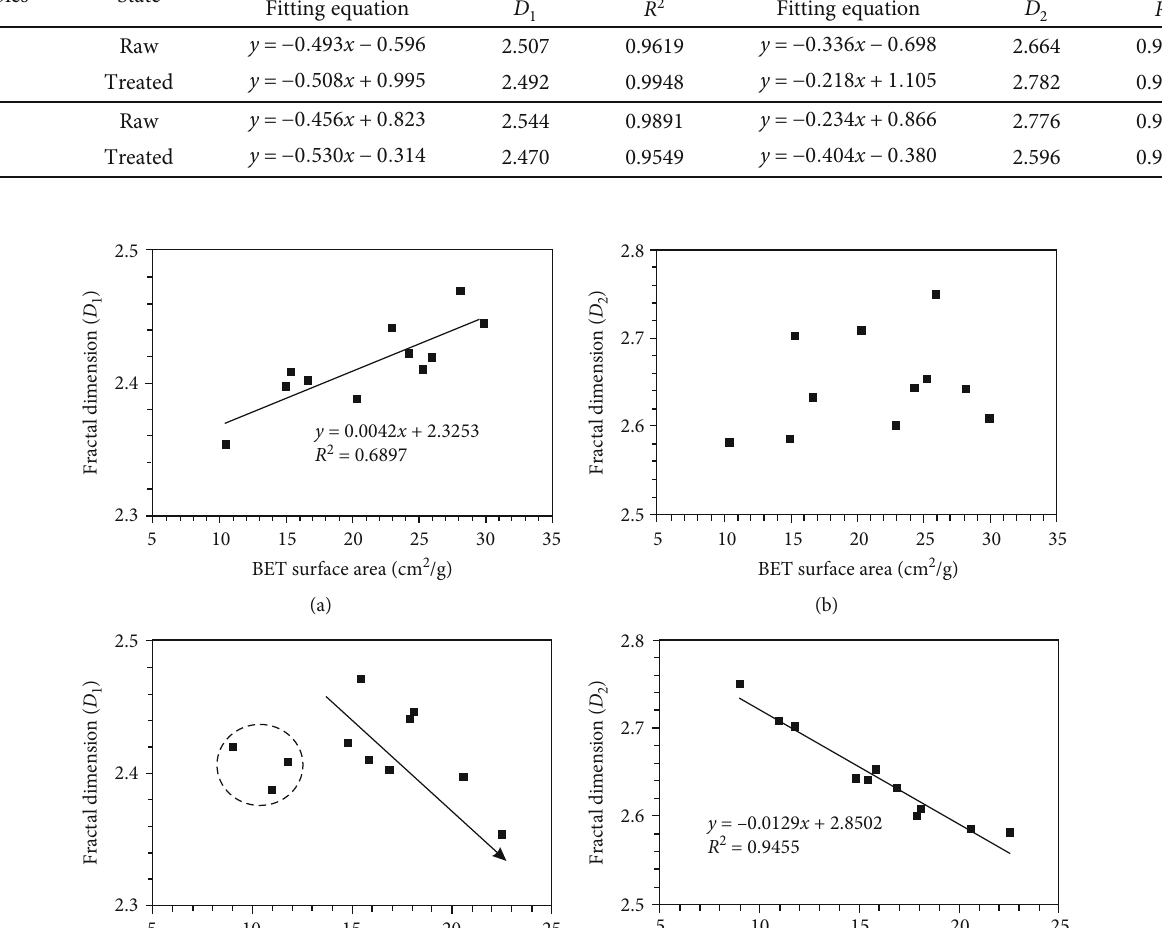
Table 5: Fractal dimensions of the shale samples before and after slick water treatment. Samples